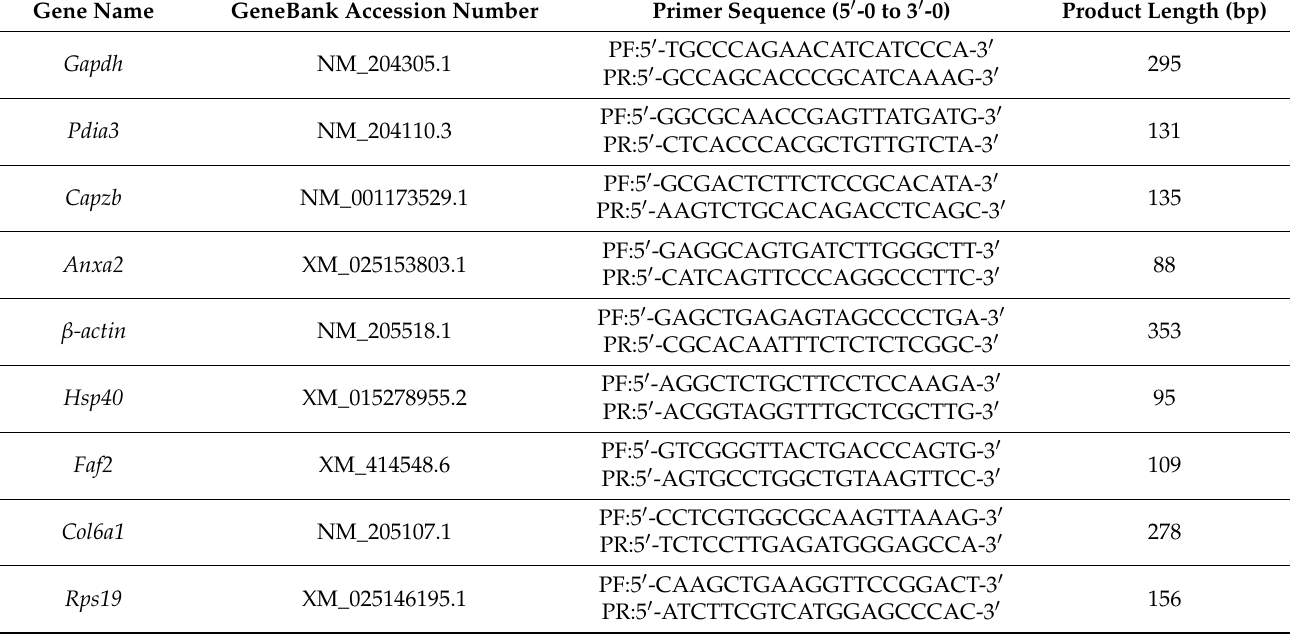
Table 1. The primers used for real-time quantitative